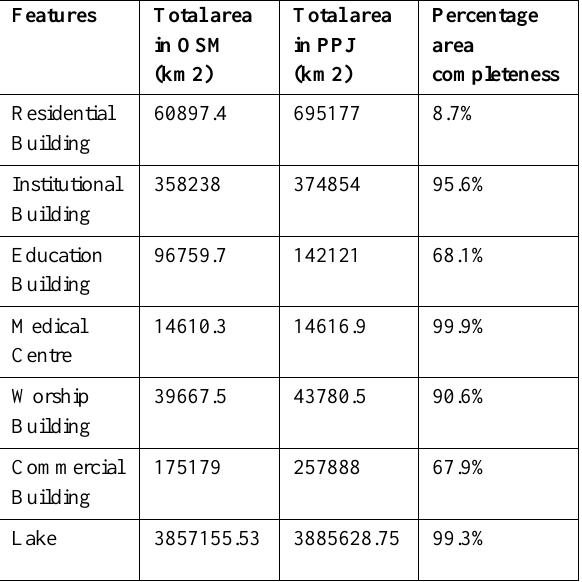
Table 8: Completeness of building features section